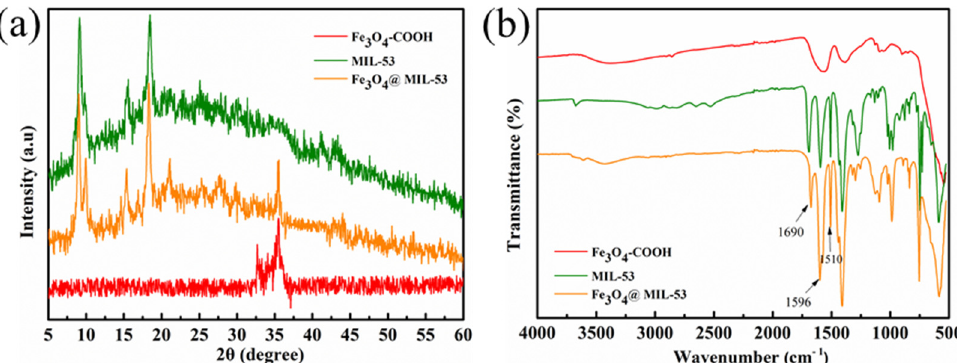
Figure 1. ( a ) XRD pattern of Fe 3 O 4 -COOH, MIL-53(Al) and Fe 3 O 4 @MIL-53(Al); ( b ) FT-IR spectra of Fe 3 O 4 -COOH, MIL-53(Al) and Fe 3 O 4 @MIL-53(Al).